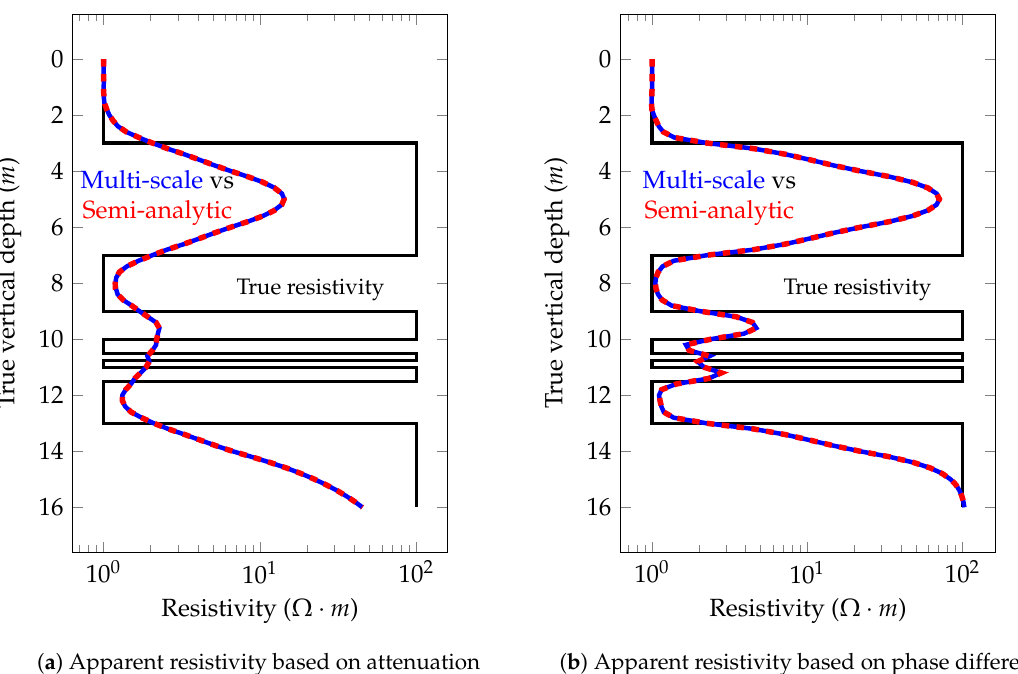
Figure 11. Model problem 2. Apparent resistivity for the zz coupling for a vertical well (dip angle = 0 ◦ ).